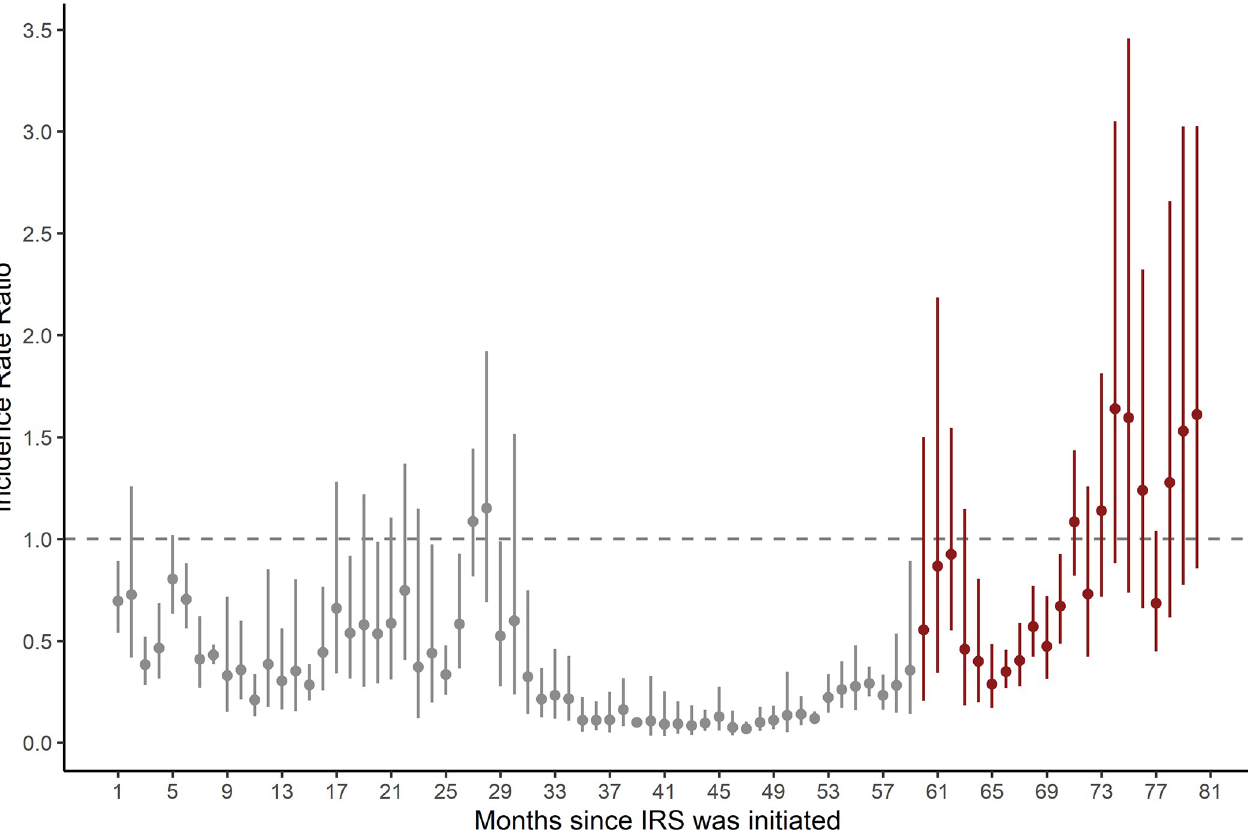
Fig 3. Adjusted IRR from multilevel negative binomial model comparing the period after IRS was initiated to the period before IRS was initiated. Vertical bars represent the 95% CI around adjusted IRR. Effect estimates in grey are published previously.